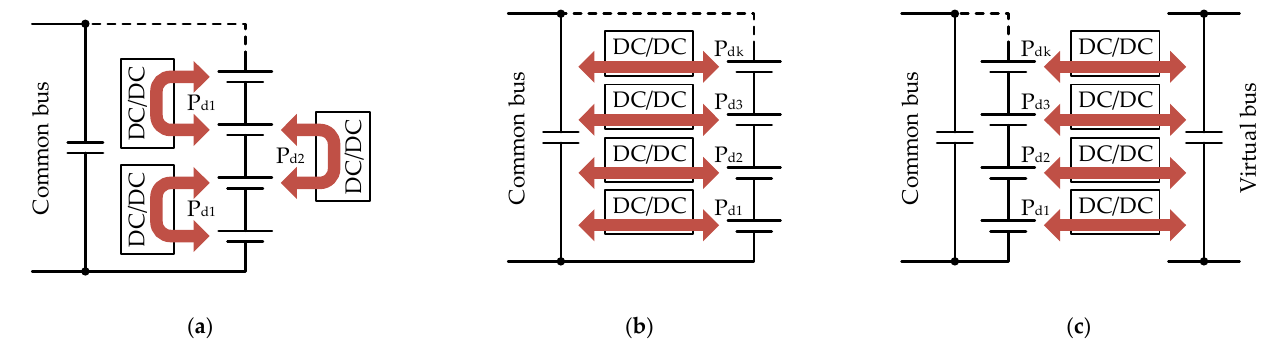
Figure 19. Differential power converters: ( a ) Element-to-Element, ( b ) Element-to-common-bus, ( c ) Element-to-virtual-bus.